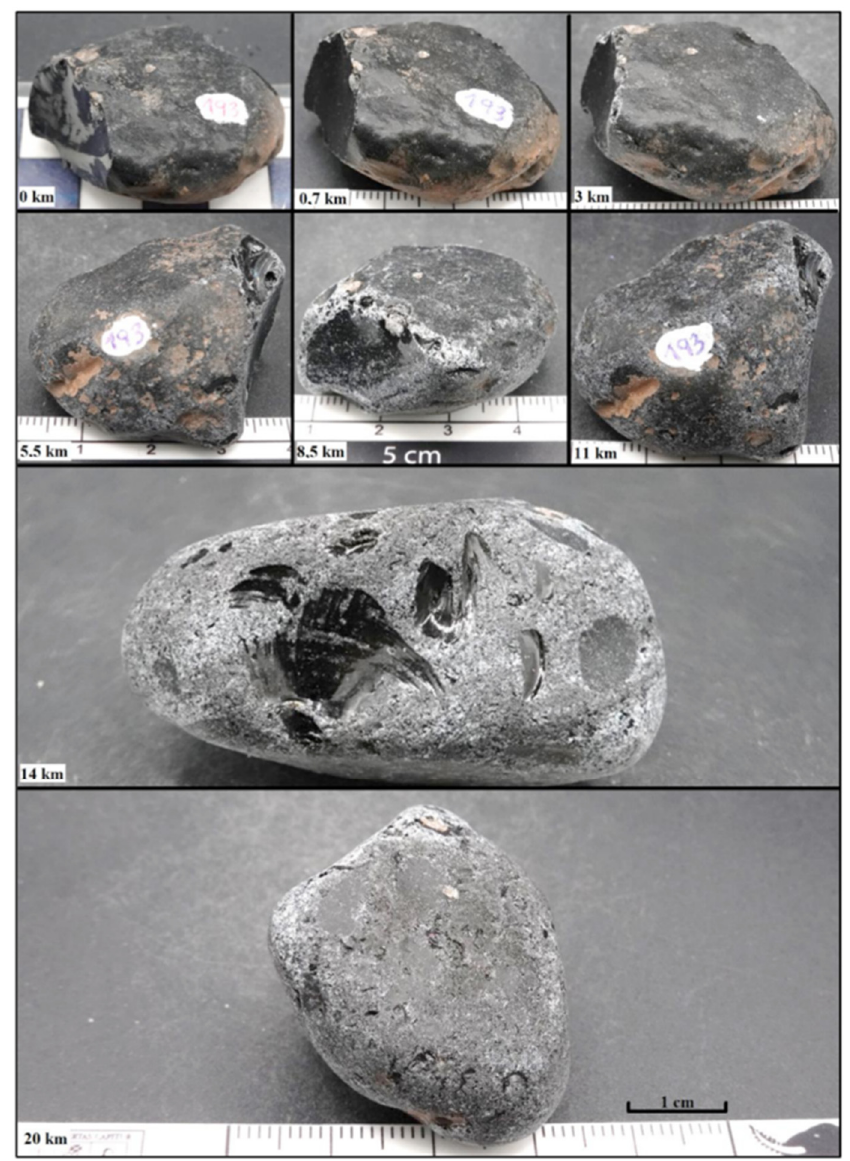
Figure 10. Sample 193, intentionally broken clast. Transport effects (from 0 to 20 km).